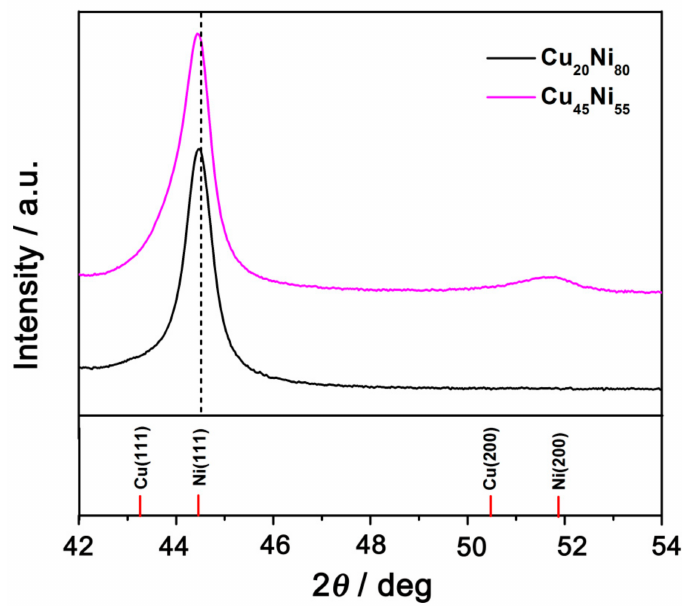
Figure 7. Zoomed-in view of the XRD patterns of surface-mesostructured Cu 20 Ni 80 and Cu 45 Ni 55 films.